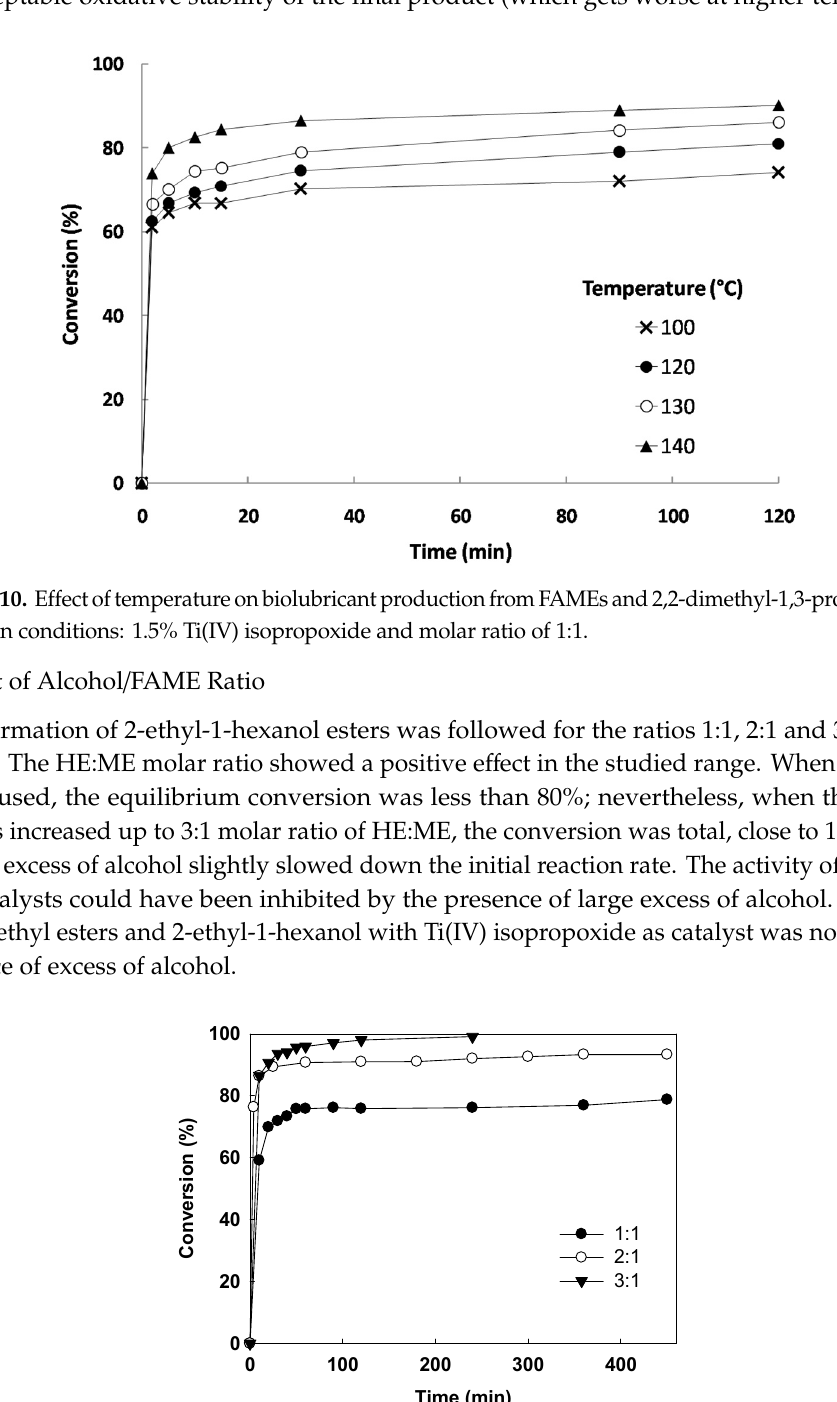
Figure 9. Effect of temperature. Reaction conditions: 1% Ti(IV) isopropoxide and HE:ME molar ratio of ( a ) 2:1 and ( b ) 1:1.